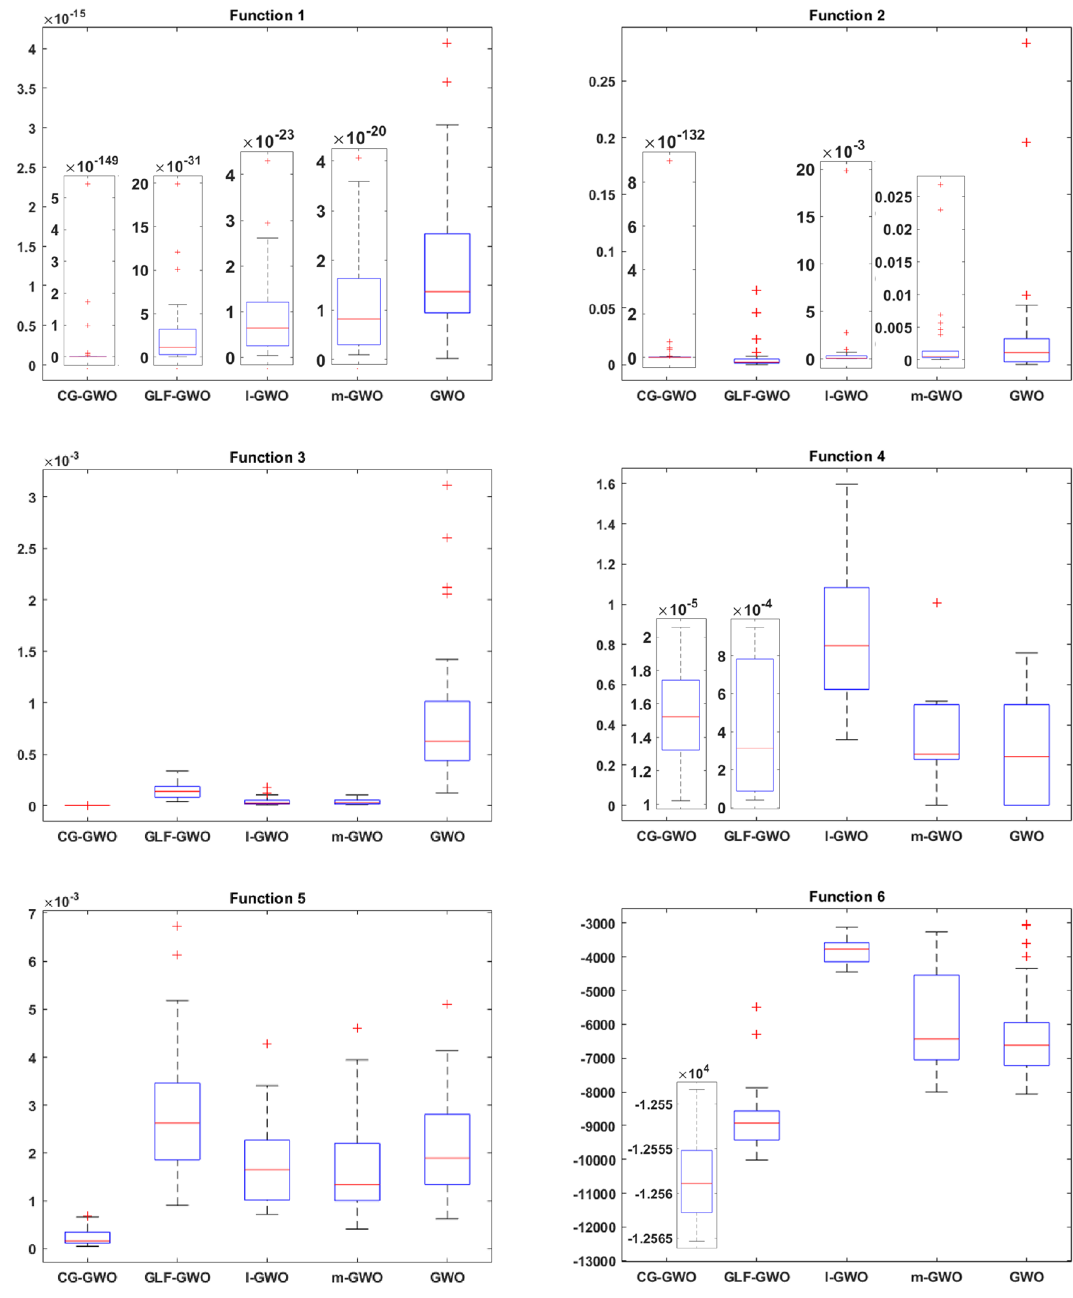
Figure 8. Boxplot comparison of improved GWO